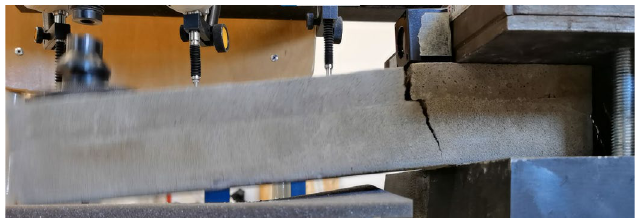
Figure 27. Delamination of specimen 24030420 after load test (composite FC and CC).